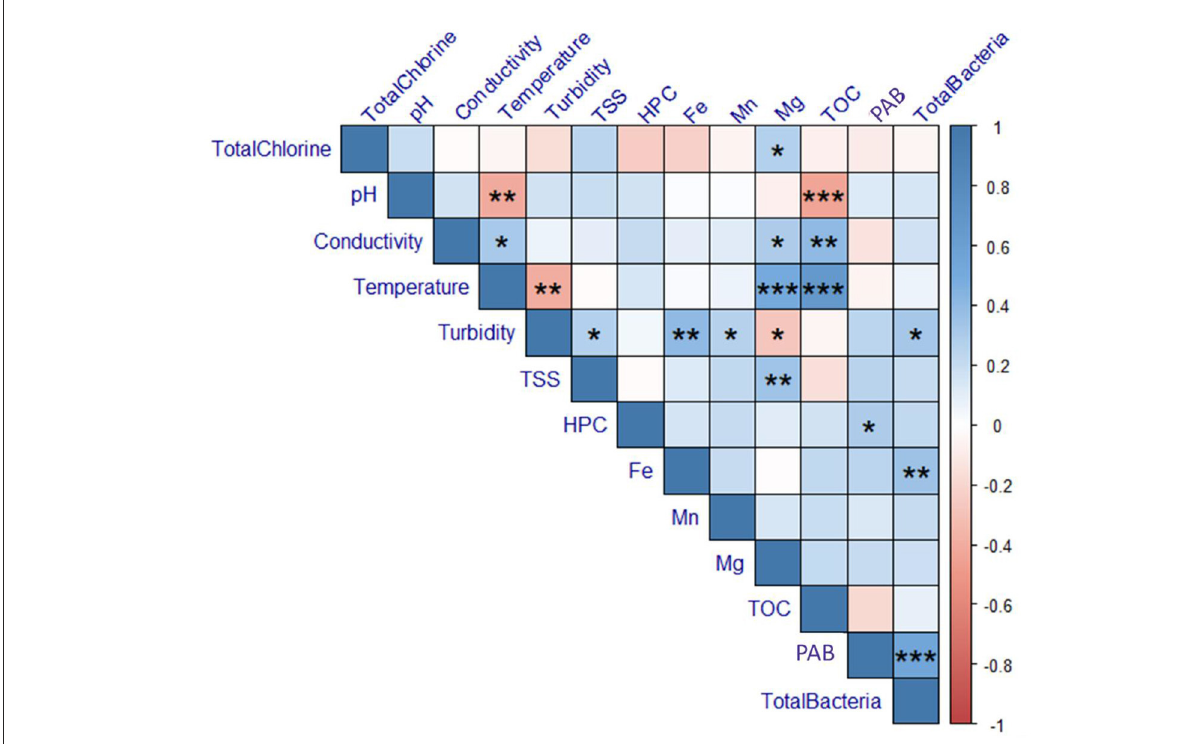
FIGURE8 Correlations calculated for physicochemical and microbiological data for all sampling dates. Color indicates the magnitude of the Spearman’s Correlation Coefficient ( ρ ). P -values are indicated as *0.05, **0.01, and ***0.001. Boxes that do not contain asterisks represent correlations